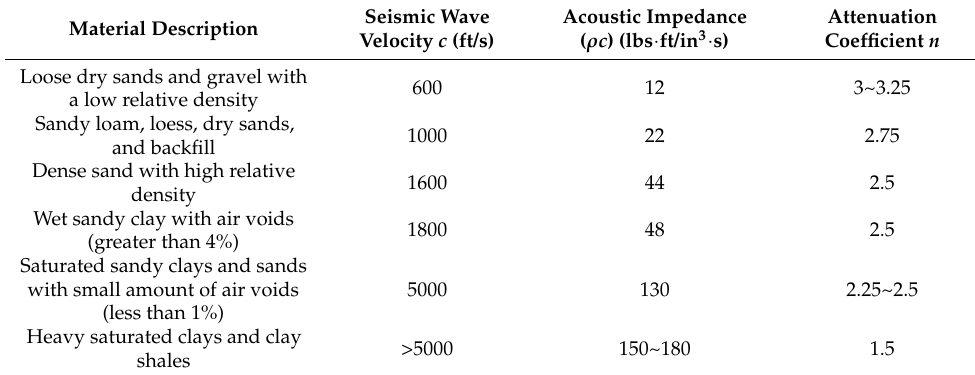
Table 2. Soil properties for calculating ground shock parameters